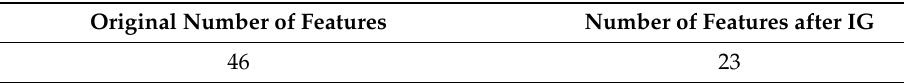
Table 3. Reduced features by Information Gain.